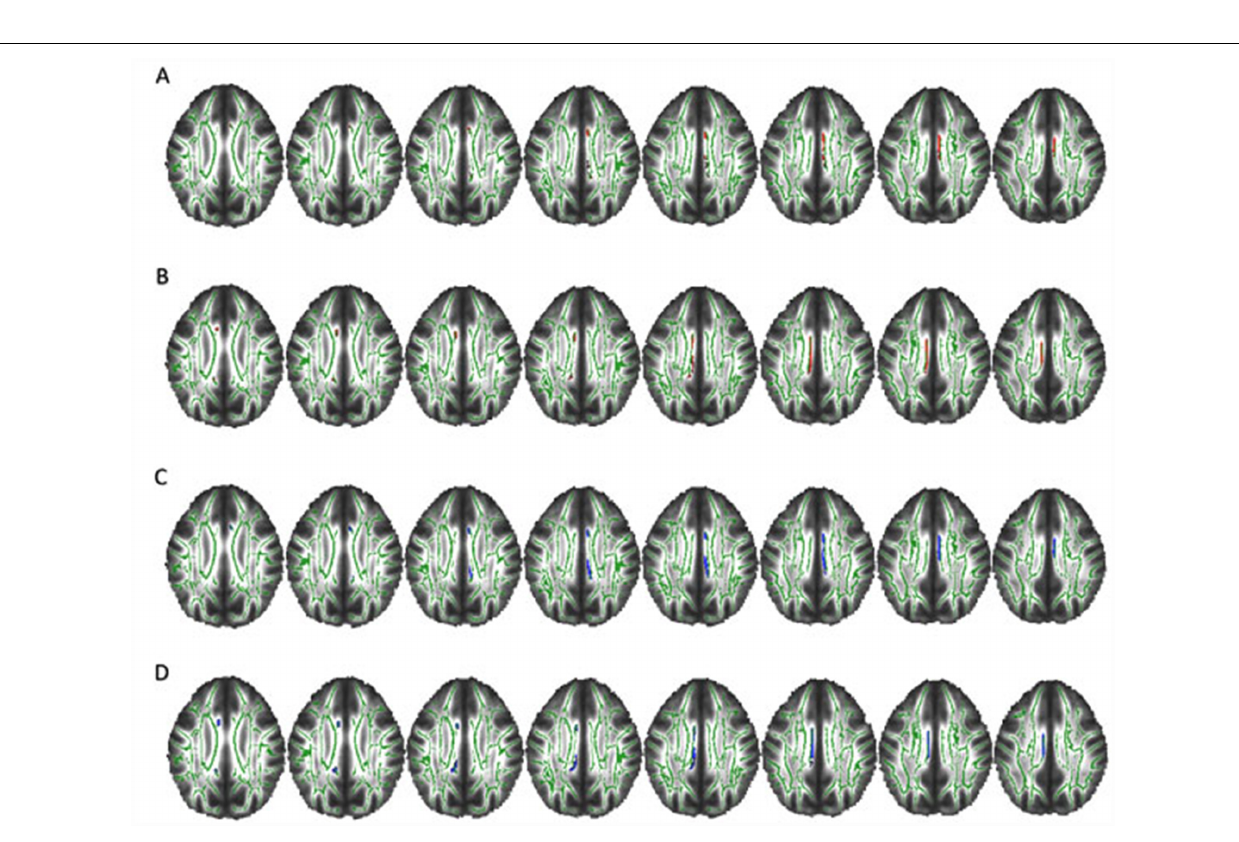
Frontiers in Human Neuroscience |